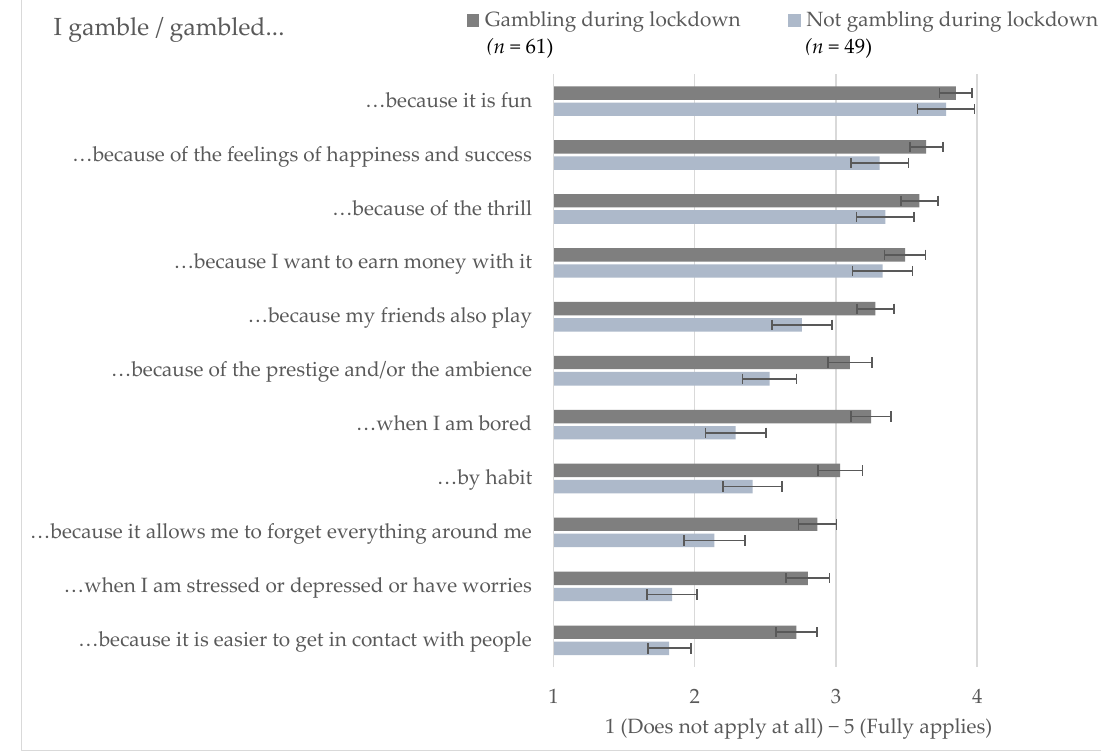
Figure 2. Gambling motives for respondents who gambled or did not gamble during lockdown. The bars indicate the mean values of five-point Likert scales. The error bars represent the mean +/- the standard error of the mean.